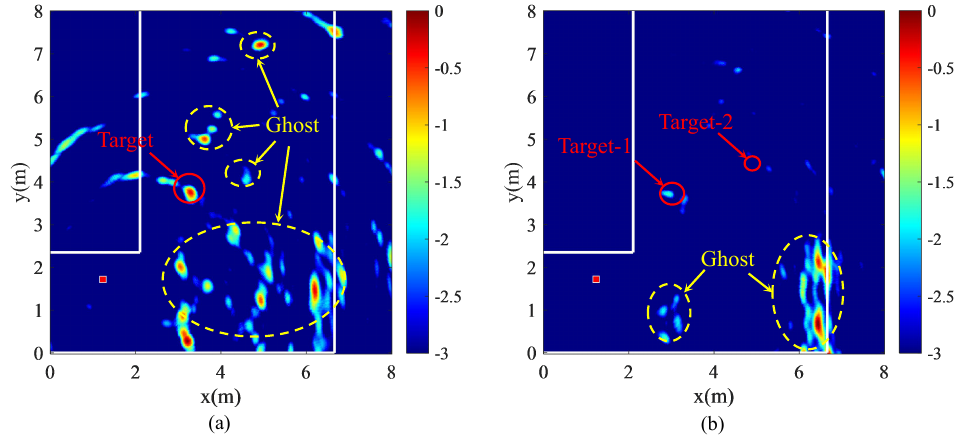
Figure 5. Imaging results of direct incoherent addition of six paths. ( a ) Result of single target. ( b ) Result of double